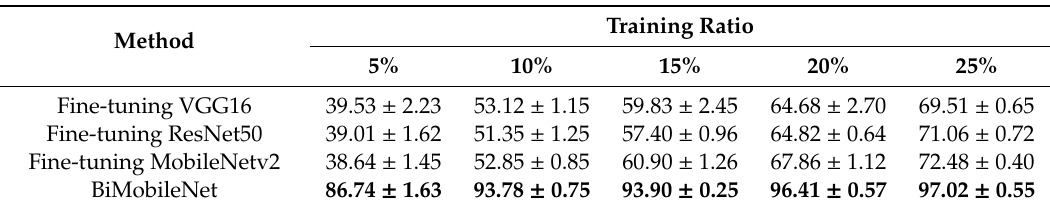
Table 4. Overall accuracy of BiMobileNet under different training ratios. The highest accuracy for each ratio is bolded.